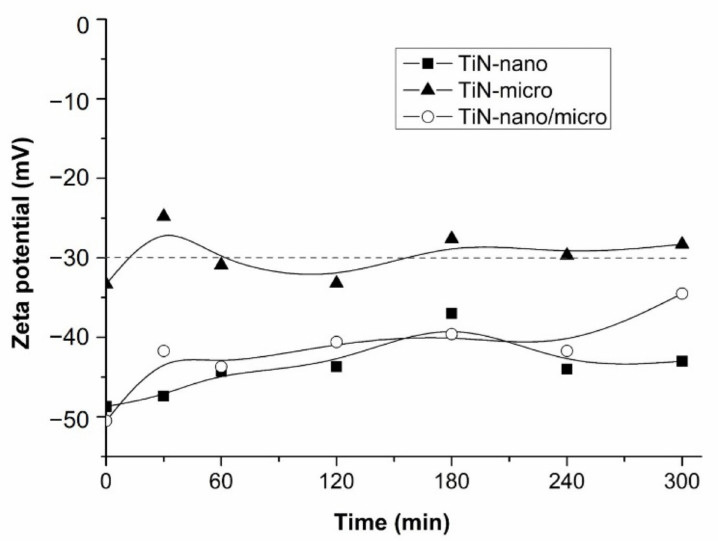
Figure 5. ζ potential stability of TiN-nano, TiN-micro, and TiN-nano/micro aqueous suspensions during time. The dash line represents the stability